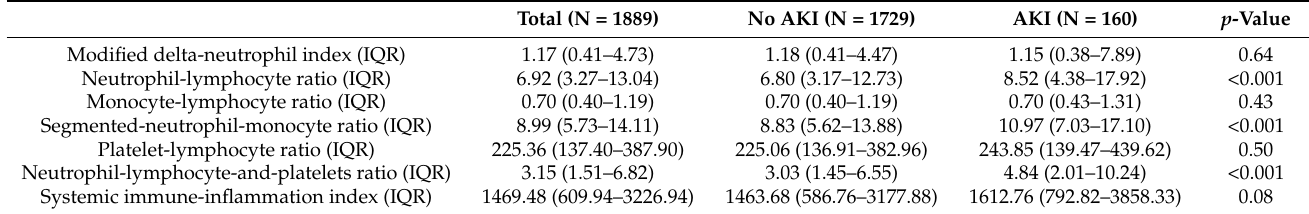
Table 2. Distribution of hematological ratios in AKI vs. non-AKI